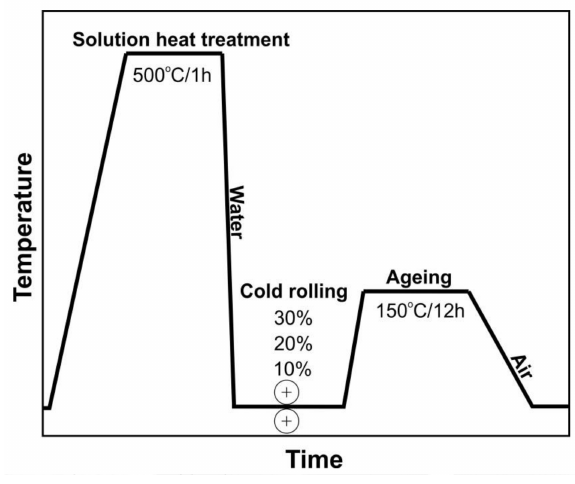
Figure 1. A schematic diagram of the low-temperature thermomechanical treatment (LTTT) of the AlZn6Mg0.8Zr